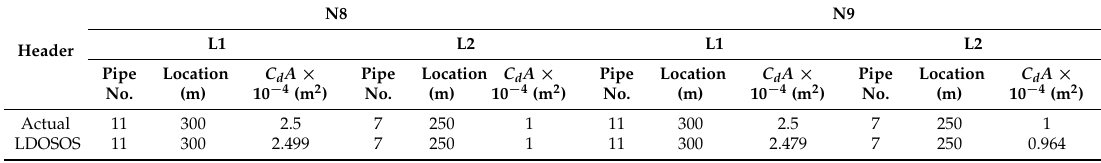
Table 5. Estimated leak information for S2 using N8 or N9.